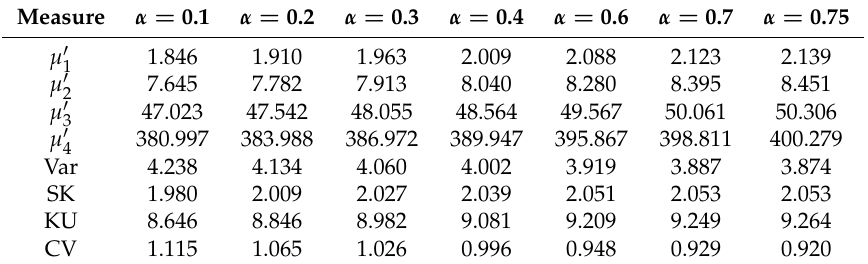
Table 2. Numerical values of some moments, variance, SK, KU, and CV of the EMIEE distribution for some selected values of α and at γ = 2.0 and β = 0.5.